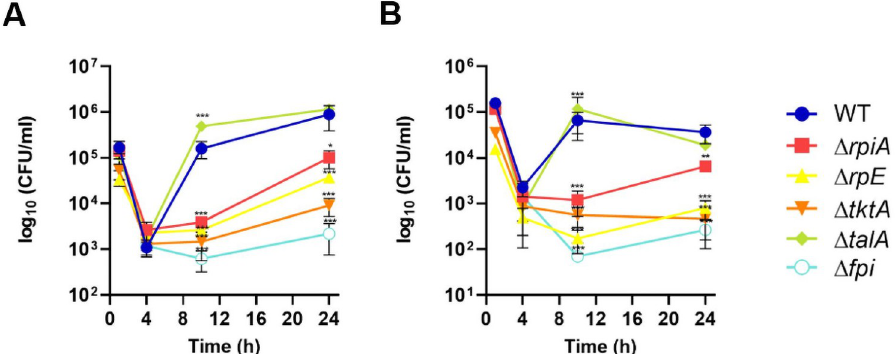
Fig 3. Intracellular multiplication of the PPP mutants. Kinetics of intracellular multiplication of the mutants was monitored in J774.1 macrophages over a 24 h-period in DMEM supplemented with either ( A ) Glucose (Glc), or ( B ) Glycerol (Gly), and compared to that in the wild-type F . novicida (WT). A Δ fpi mutant strain was used as a negative control. � , P < 0.05; �� , P < 0.01; ��� , P < 0.001 (compared to WT strain; as determined by two-way ANOVA test).